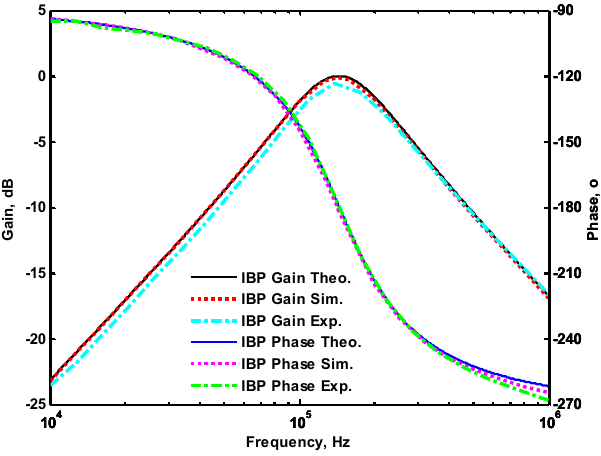
Figure 12. Experimental and simulated IBP filters with theoretical responses in case II.